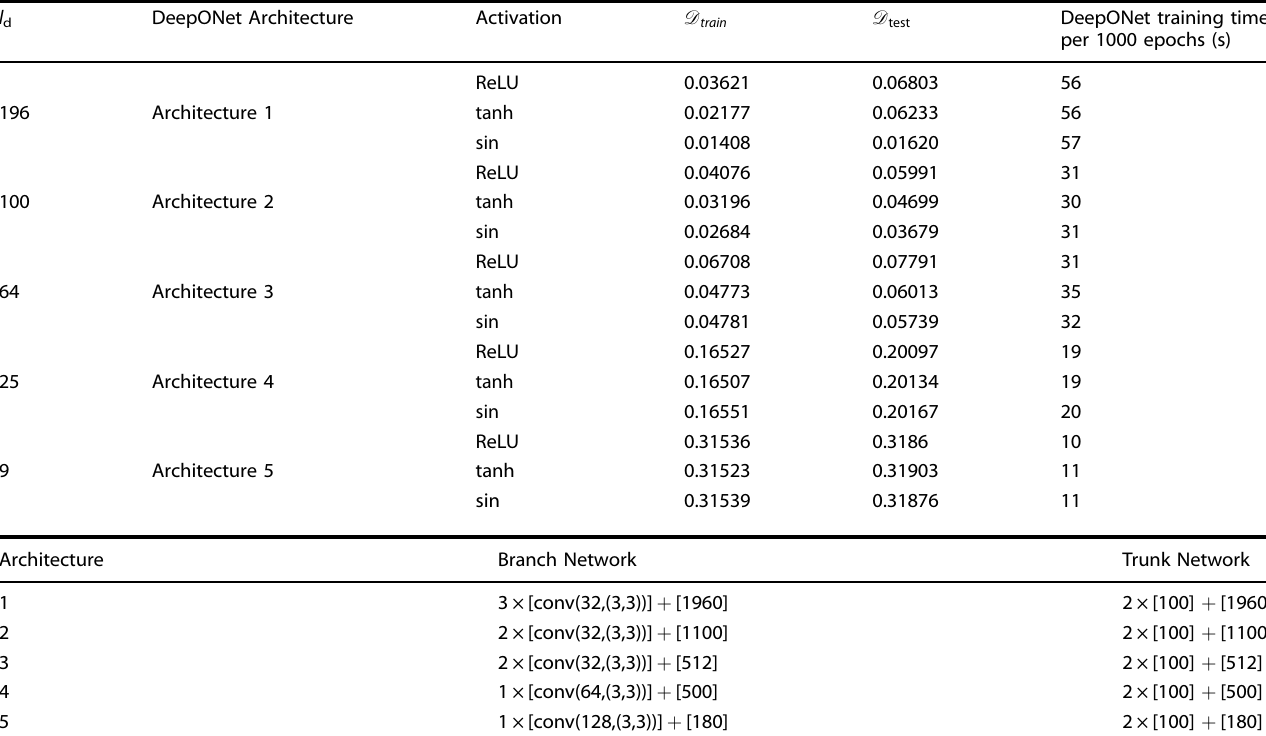
Table 2. Detailed survey of different latent dimension size, l d , network architecture, and non-linear activation